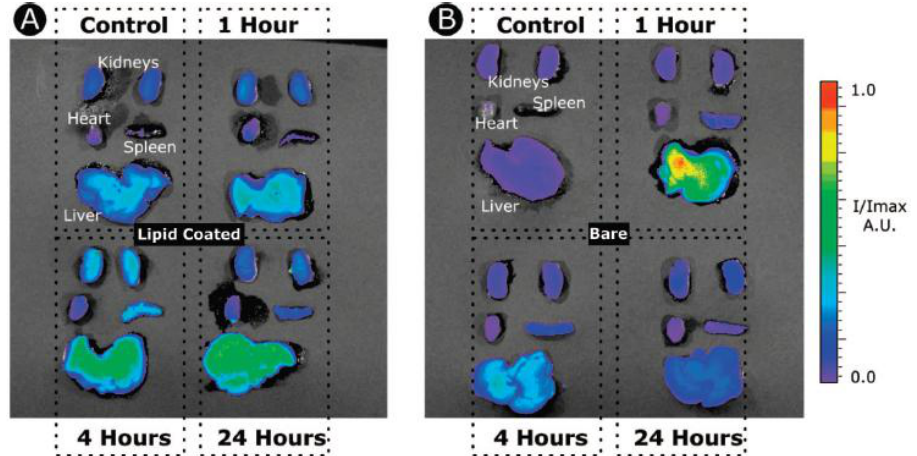
Figure 2. Fluorescence imaging of liver, spleen, kidneys, and heart of control mice and mice sacrificed 1, 4, and 24 h post-injection with (A) Lipid-coated SiNPs and (B) Bare-SiNPs. While an immediate uptake of bare silica particles in the liver was observed, the lipid-coated silica particles accumulated gradually over time in the liver which is in agreement with their prolonged circulation half-life value. Reproduced with permission from [32] ® 2008, American Chemical